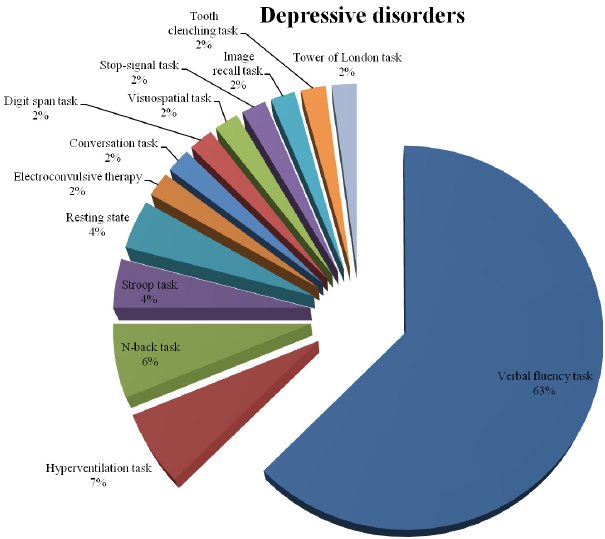
Fig. 4. Task-based distribution of studies on depressive dis- orders (total studies: